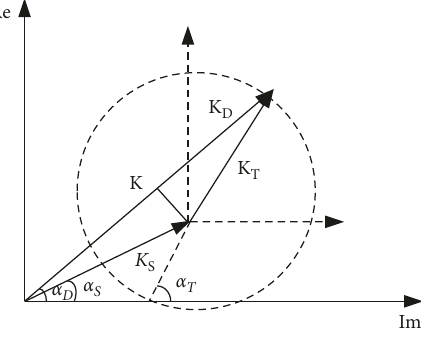
Figure 4: Phase geometry relationship